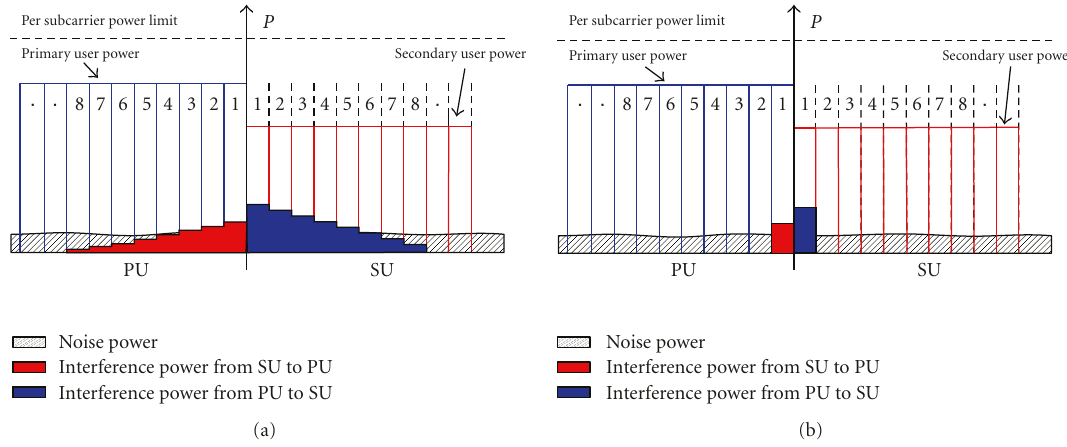
Figure 3: (a) Intercell interference between PU and SU in OFDM based CR networks (b) Intercell interference between PU and SU in FBMC based CR